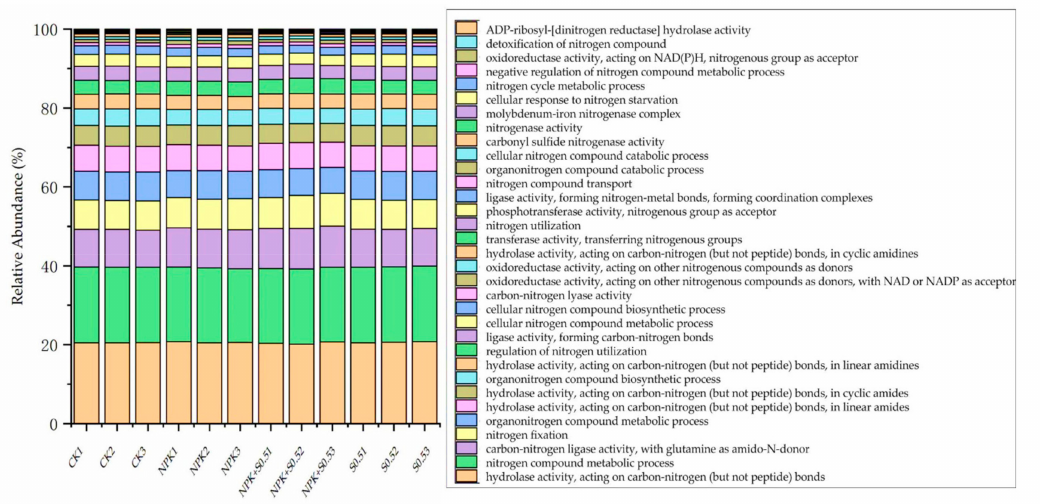
Figure 6. The relative abundance of the function of genes participating in the N cycle shown with GO annotation.